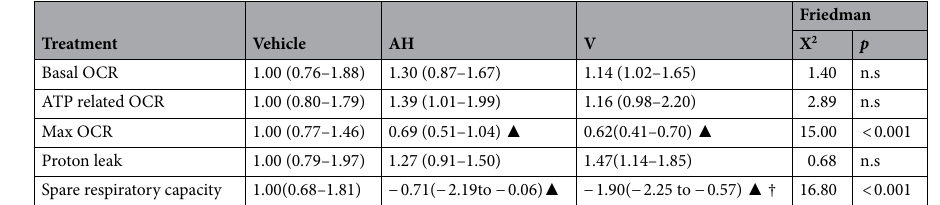
Table 4. Mitochondrial parameters into differentiated PBMCs exposed 4 h with Al-based treatments. Results are expressed as median and quartiles (in brackets) of OCR–SRC/protein quantification level normalized by vehicle median. AH, Aluminum oxyhydroxide. V, Whole vaccine (Engerix ® ). n.s., not significant. ▲ p < 0.05 compared to vehicle treatment. † p < 0.05 compared to AH